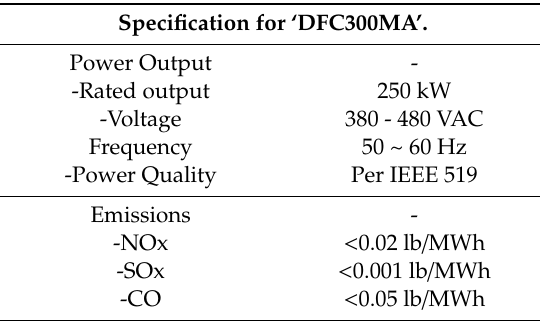
Table 1. Specification of the fuel cell system.